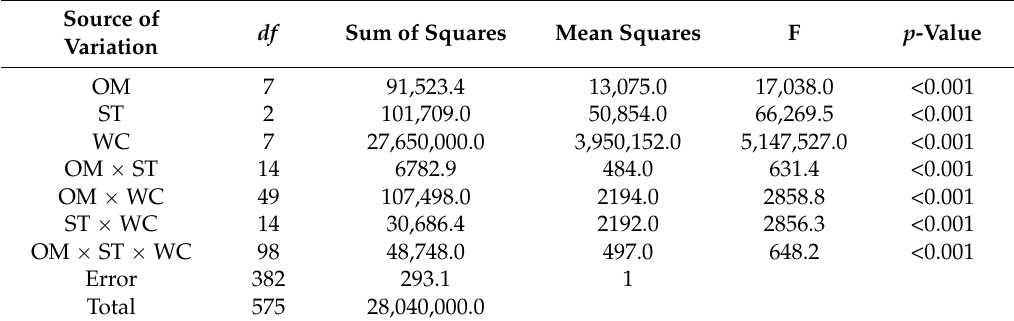
Table 1. Analysis of variance of sensor readings (RC) as a function of organic matter level (OM), sensor type (ST), and water content (WC).